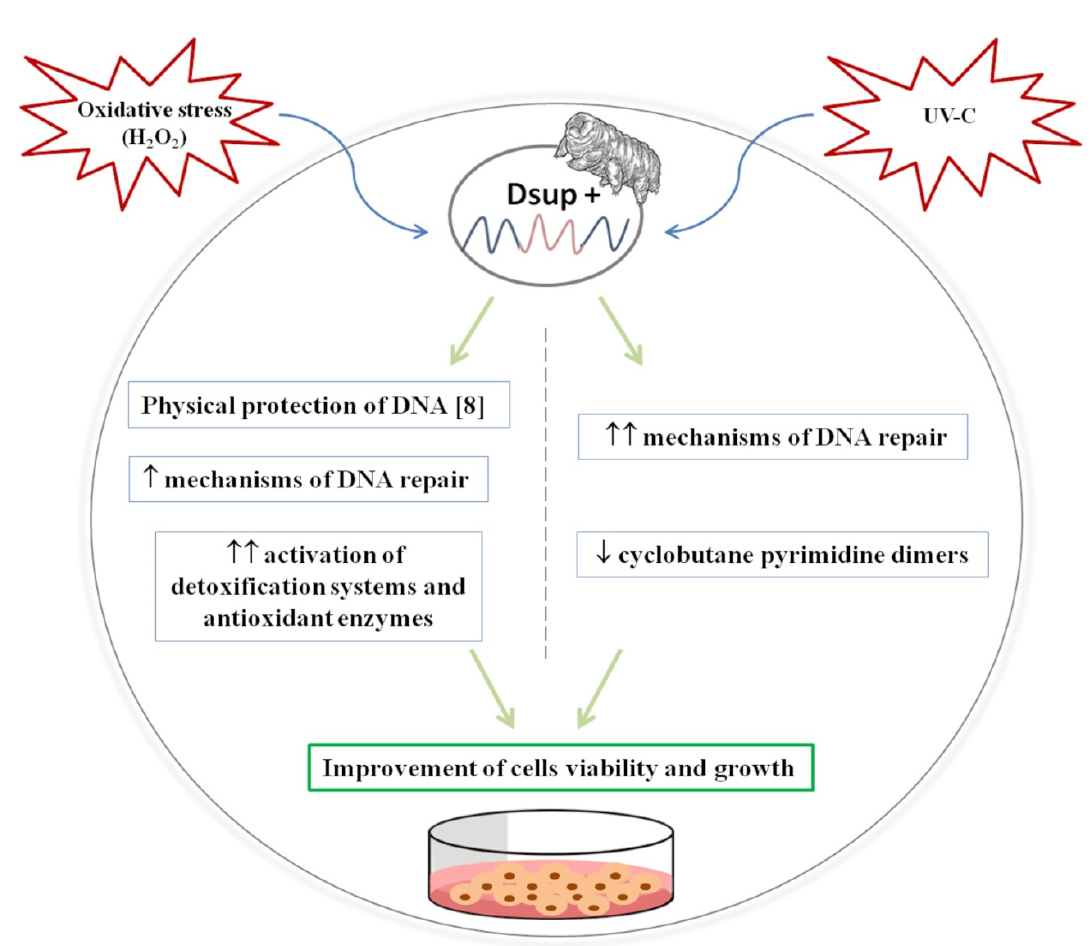
Figure 5. Schematic model of protection mechanisms in mammalian cells expressing Dsup protein (Dsup+) exposed to oxidative stress and UV-C irradiation. After H 2 O 2 treatment, Dsup+ cells mainly activate the detoxification system and antioxidant enzymes limiting oxidative stress, while DNA repair mechanisms are moderately turned on, probably due to DNA “physical” protection mediated by Dsup [8]. On the other hand, after UV-C exposure, Dsup+ cells respond by activating more efficient DNA repair genes reducing cyclobutane pyrimidine dimers formation. All these protective mechanisms give Dsup+ cells a greater resistance to external stress, improving their viability and growth respect to untransfected cells. ↑ : moderate; ↑↑ : high; ↓ : low/reduced.